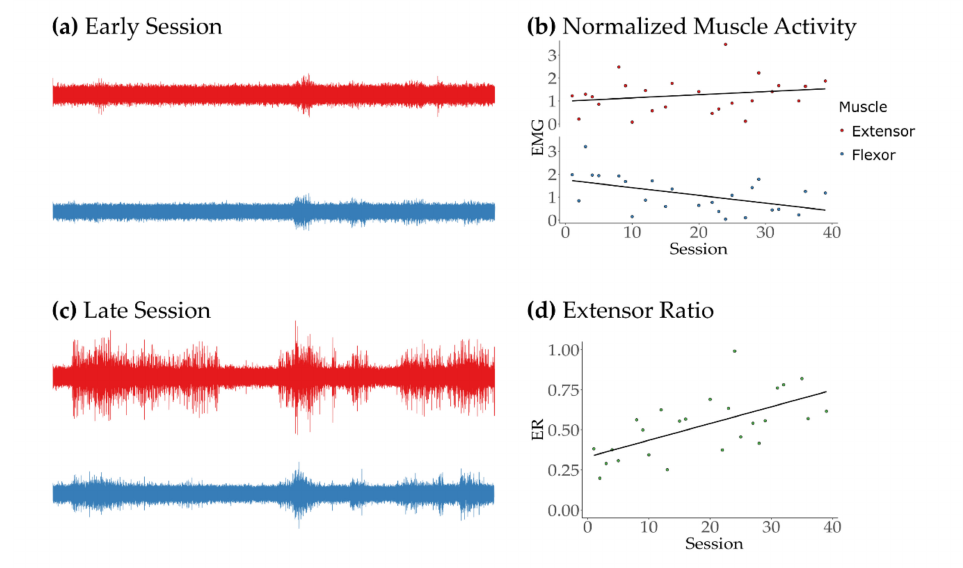
Figure 5. Muscle activity during REINVENT Sessions. Example of representative activity from the extensor (red) and flexor (blue) muscles during the calibration of early ( a ) and late ( c ) trials. The calibration algorithm looks at the recorded activity during which a video cued movement attempts and calculates the highest rectified muscle activity of a 250-ms moving window average for each muscle. These values are later used to normalize the activity during each trial and calculate extensor ratios (ER) to control the game. ( b ) Normalized muscle activity (EMG) averaged across 40 sessions for extensor and flexor muscles. Changes over time were not significant. ( d ) Calculated values of ER averaged across 40 sessions. A significant increase in extension individuation appeared during movement attempts ( p < 0.01). Regression lines are shown for visualization in panels ( b ) and ( d